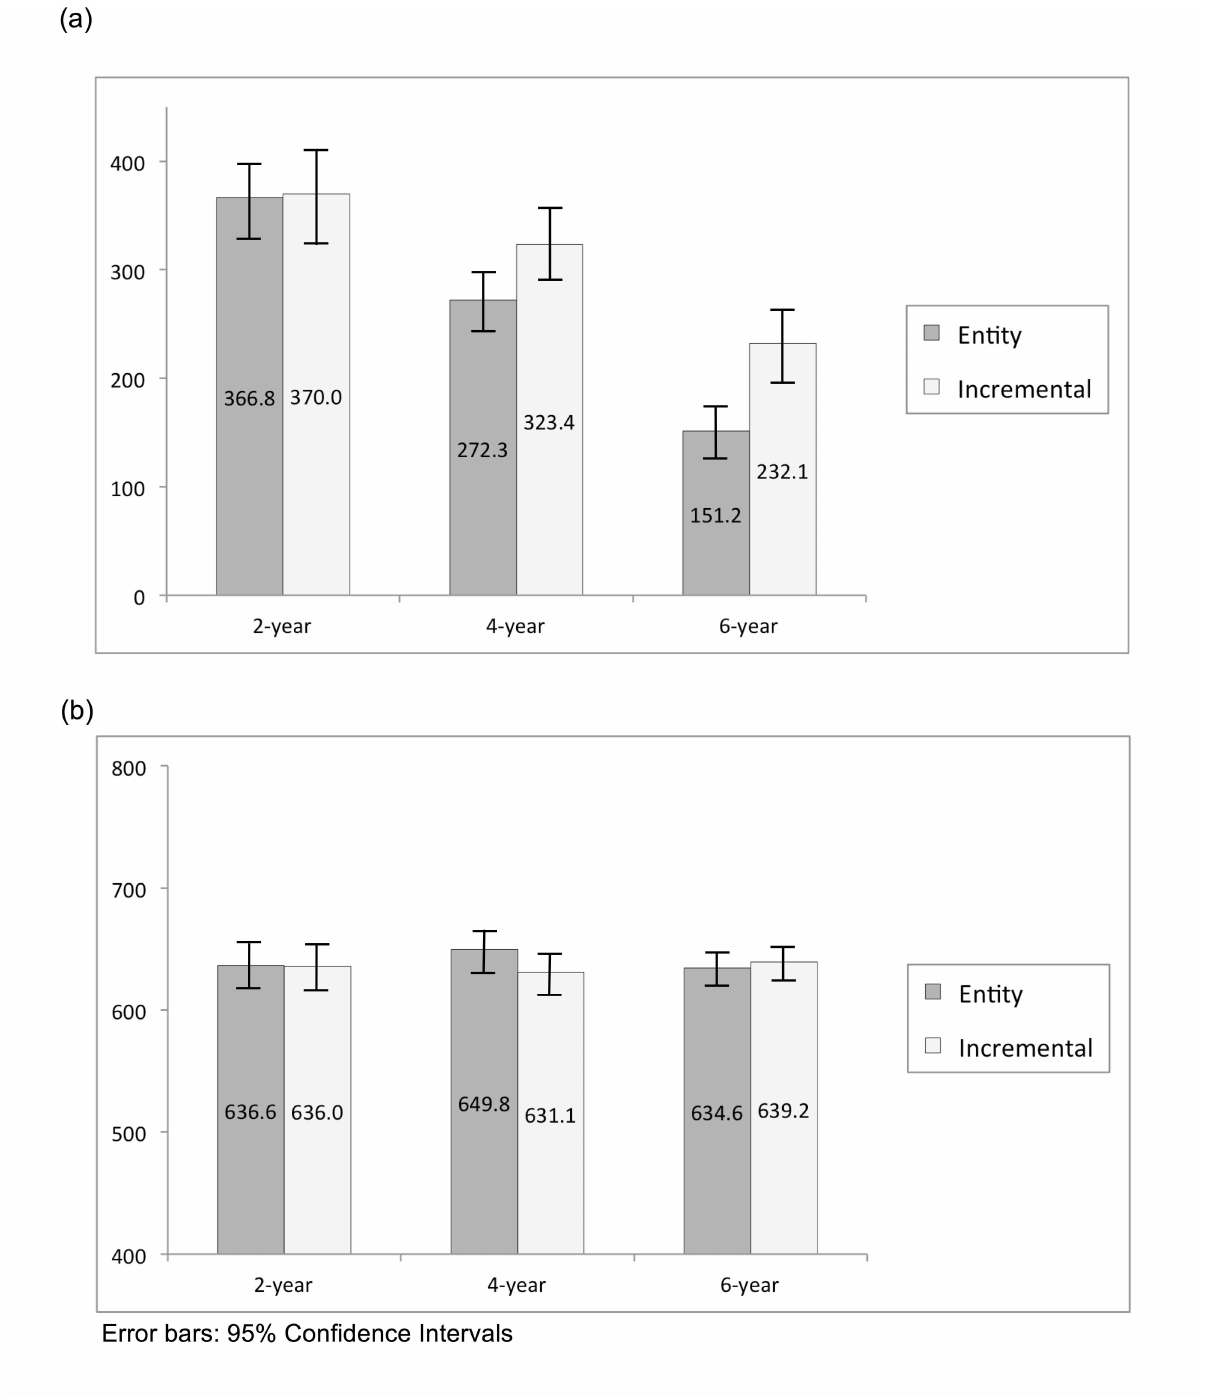
Fig 1. Study 1a –Estimated Average of the Monetary Contribution per Year. (a) The range of the estimated average(the difference between the possible maximum and the minimum averages(unit: US dollar). (b) The midpoint of the range (unit: US dollar). Error bars: 95% Confidence